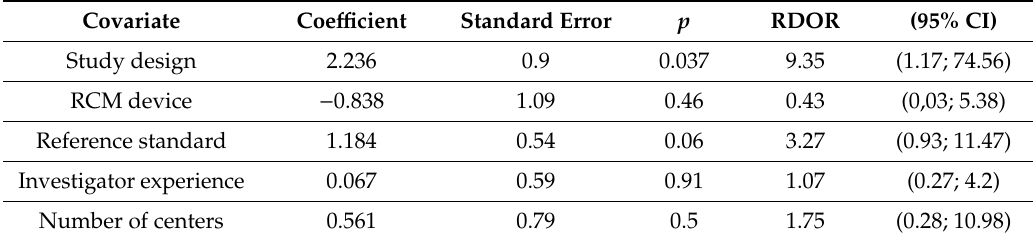
Table 3. Results of the meta-regression for heterogeneity sources.